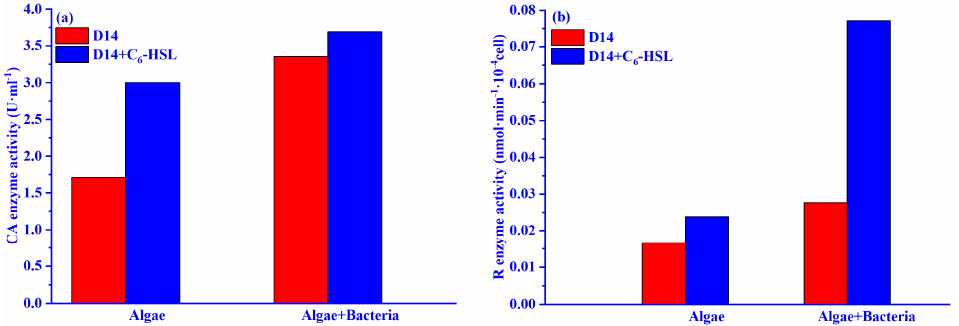
Figure 5. Effect of 10ng/L C 6 -HSL on ( a ) CA and ( b ) Rubisco of algae group and algae–bacteria group. Algal+C 6 -HSL and algae+bacteria+C 6 -HSL are algae group and algae–bacteria group treated with C 6 -HSL, respectively. Phase I is without the addition of C 6 -HSL, and Phase II is with the addition of C 6 -HSL.